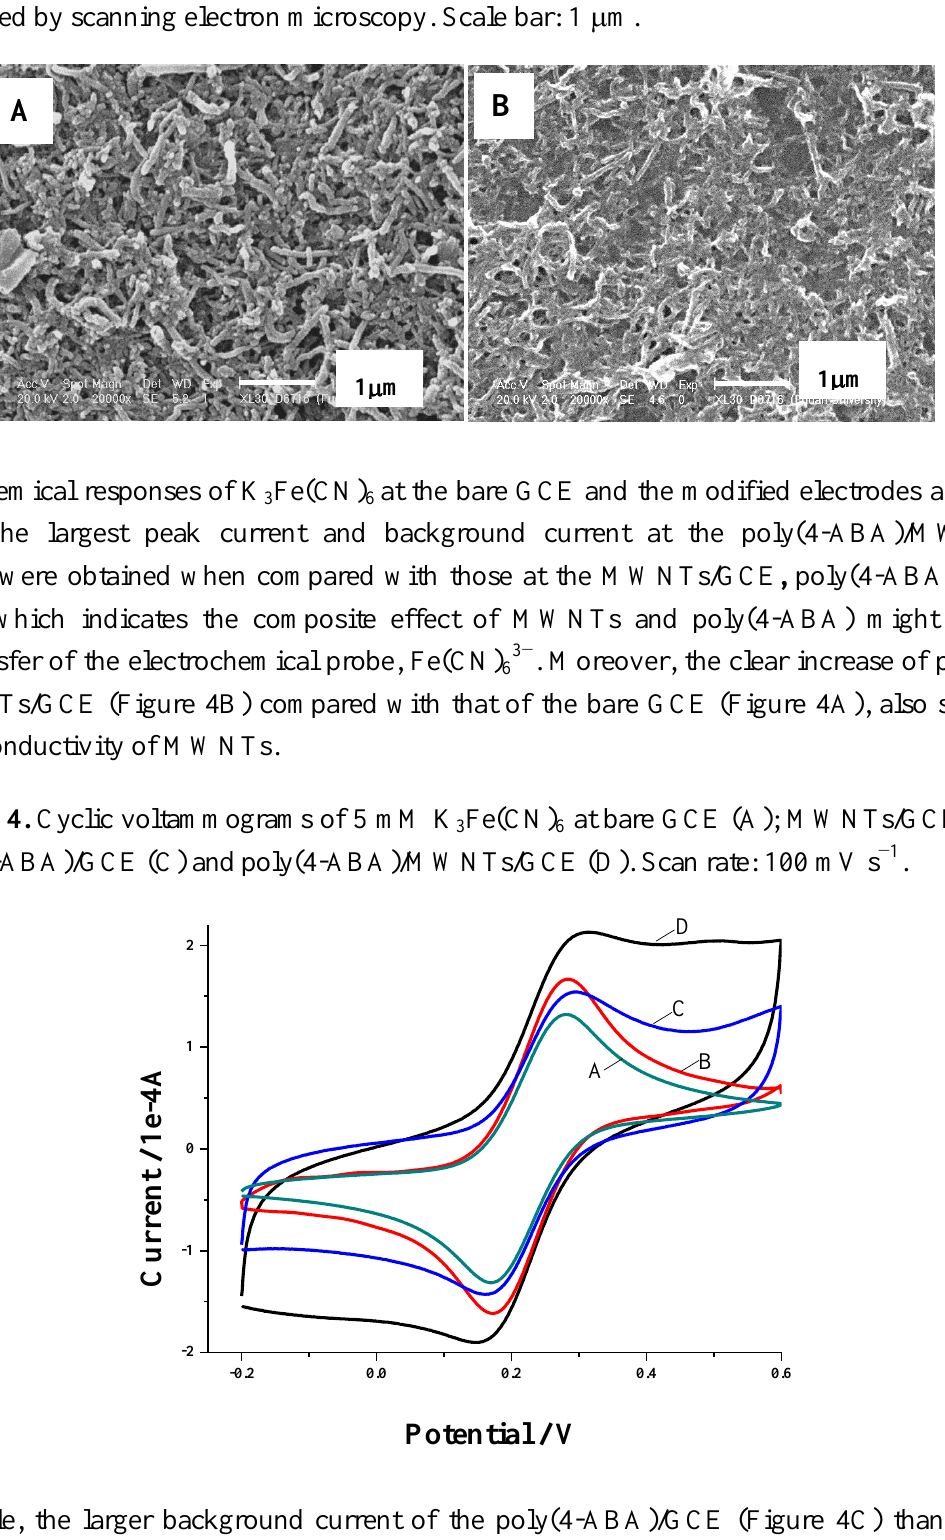
Figure 3. The surface images of MWNTs/GCE (A) and poly(4-ABA)/MWNTs/GCE (B) produced by scanning electron microscopy. Scale bar: 1  m.